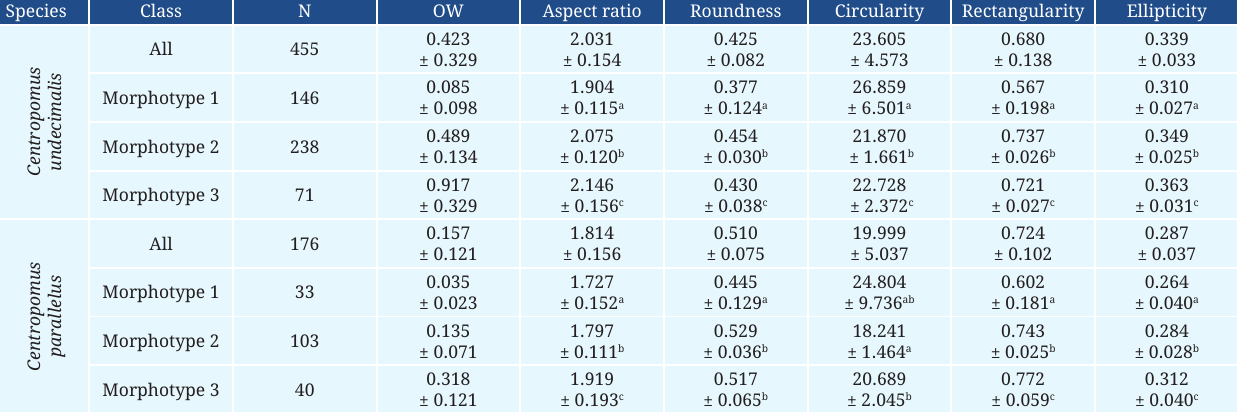
TABLE 2 | Morphometric relations and shape index of the otoliths of Centropomus undecimalis and C. parallelus per morphotype. Means with the different lower-case letter superscripted are significantly different (P < 0.05). OW = Otolith weigh. Species Class N OW Aspect ratio Roundness Circularity Rectangularity